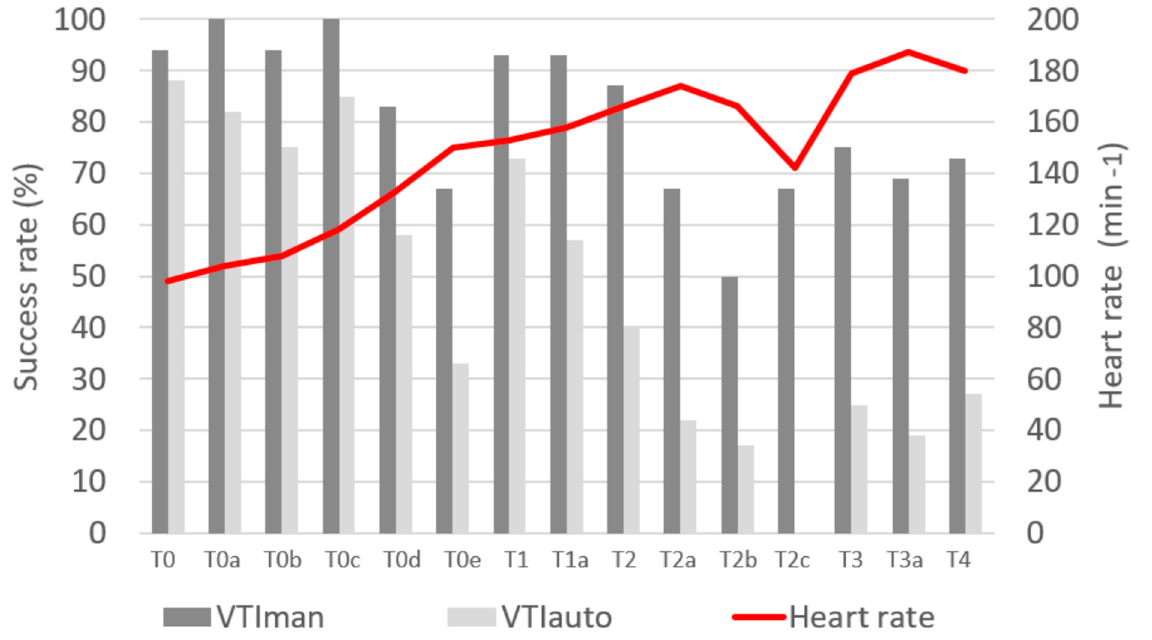
Figure 2. Feasibility according to the experimental time of manually measured sub-aortic velocity time index (VTIman) and automatically measured sub-aortic velocity time index (VTIauto).